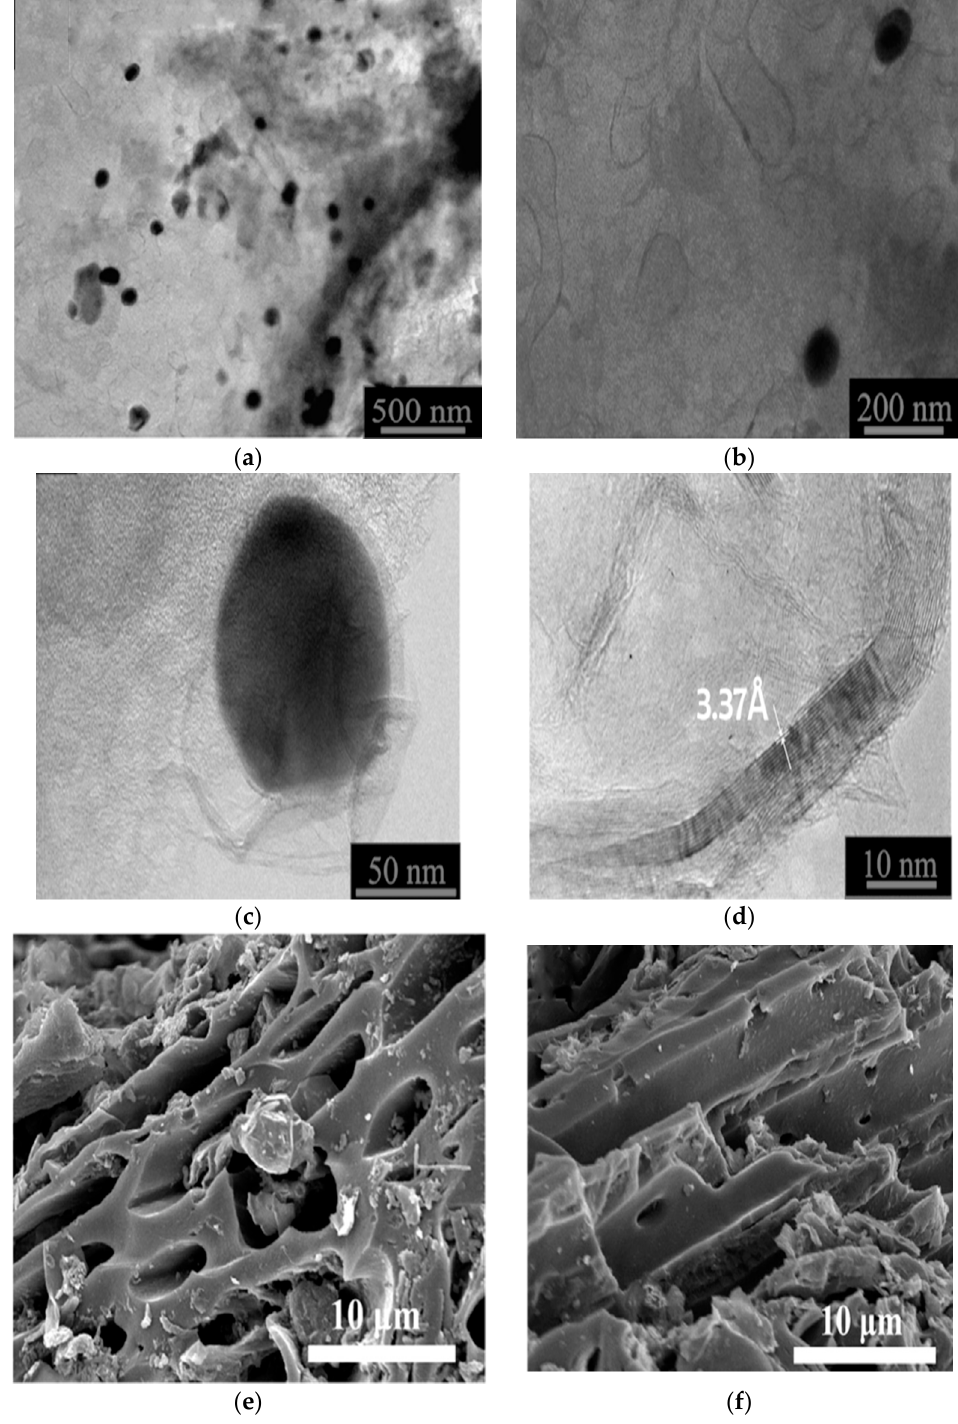
Figure 1. TEM images ( a – d ) and SEM images ( e , f ) of Fe 3 O 4 /N@C nanocomposite. For further morphology investigation of granulated Fe 3 O 4 /N@C nanocomposite,